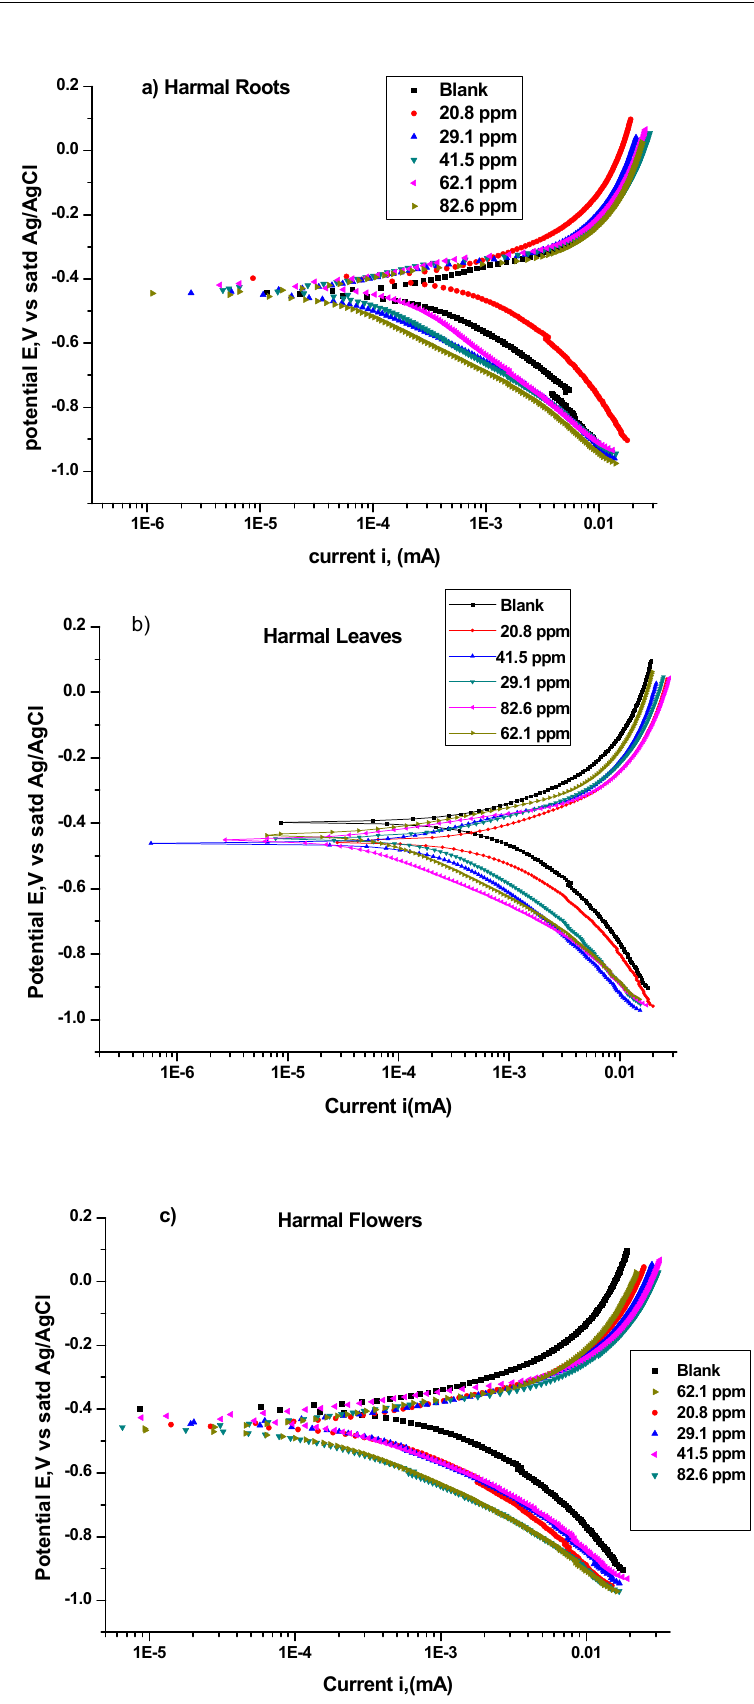
Figure 9. Tafel plots for all concentrations of ( a ) Harmal roots, ( b ) Harmal leaves, and ( c ) Harmal flowers extract inhibitors in 0.25M H 2 SO 4 at 298 K. The analysis of the Tafel polarization curves is computed using the Gamry software v7.07, and the results are presented in Table 8 (HRE), Table 9 (HLE), and Table 10 (HFE). The equilibrium corrosion potential ( E corr) values shifted to more negative values for the inhibitor in comparison with the blank solution. But the potential E corr does not follow a consistent increase with increasing concentration of inhibitors. This was also observed in other reported works [42,56]. The inhibitors could be classified as mixed-type inhibitors [52]. But there is a consistent I corr current decrease with increased concentration, which clearly indicates the enhancement of inhibition. Thus, the current values are more reliable than the potential values to evaluate inhibition efficiency.